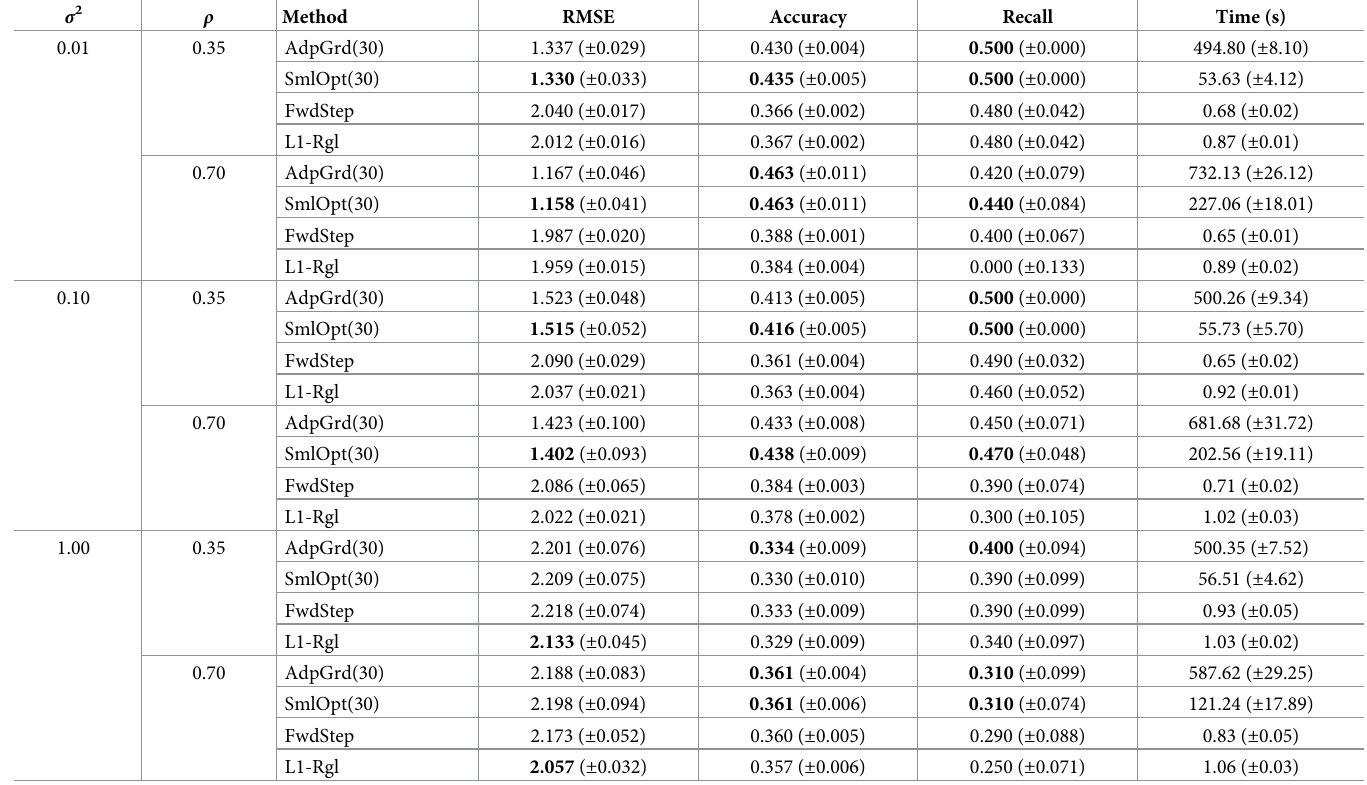
Table 3. Prediction performance for synthetic test instances ( θ =